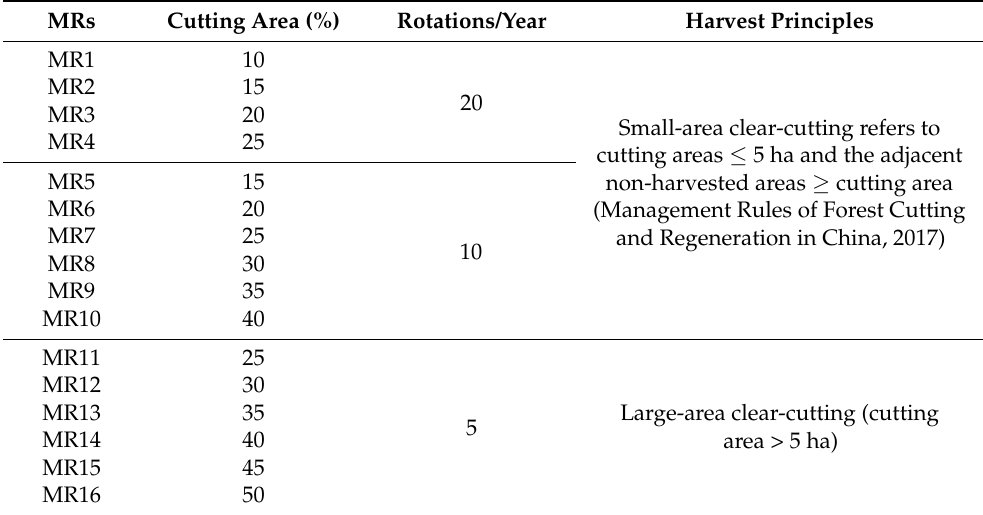
Table 2. Sixteen potential MRs for the Moshao forest farm were developed according to combinations of cutting area percentages, cutting periods, and harvesting principles. The intensity of cutting gradually increased from MR1 to